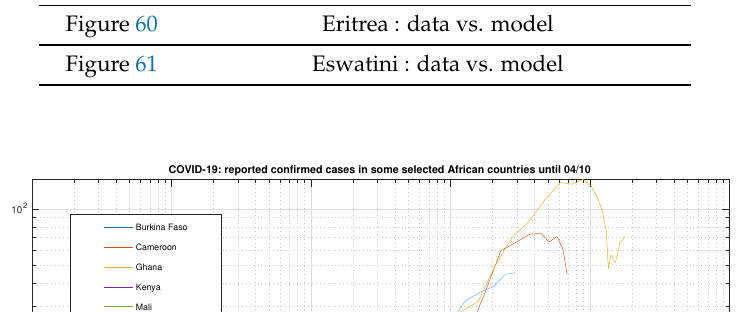
Table 6. List 3 of figures and illustrations. data of active, recovered, deceased (in circle or bar) vs. model of active, recovered, deceased over time. Tracking the number of active cases. Predictive analytics for the next couple days. Illustration Meaning Figure 45 Covid-19 samples in selected countries in Africa Figure 46 Selected COMESA countries Figure 47 Selected ECOWAS countries Figure 48 Selected SADC countries Figure 49 Tunisia: Sequential data-driven model Figure 50 Algeria: data vs. model Figure 51 Angola: data vs. model Figure 52 Botswana: data vs. model Figure 53 Benin: data vs. model Figure 54 Burkina Faso : data vs. model Figure 55 Burundi : data vs. model Figure 56 Cameroon : data vs. model Figure 57 Chad : data vs. model Figure 58 Djibouti : data vs. model Figure 59 Egypt : data vs. model Figure 60 Eritrea : data vs. model Figure 61 Eswatini : data vs. model